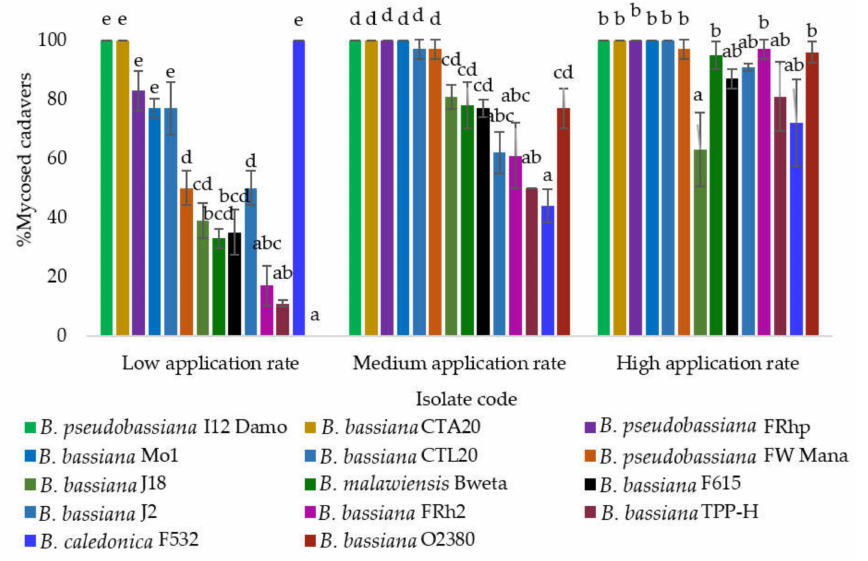
Figure 4. The percentage of diamondback moth larval cadavers that supported fungal sporulation after exposure to 14 selected isolates of Beauveria at three application rates (error bars following letters represent ANOVA, multiple comparisons using Tukey’s HSD